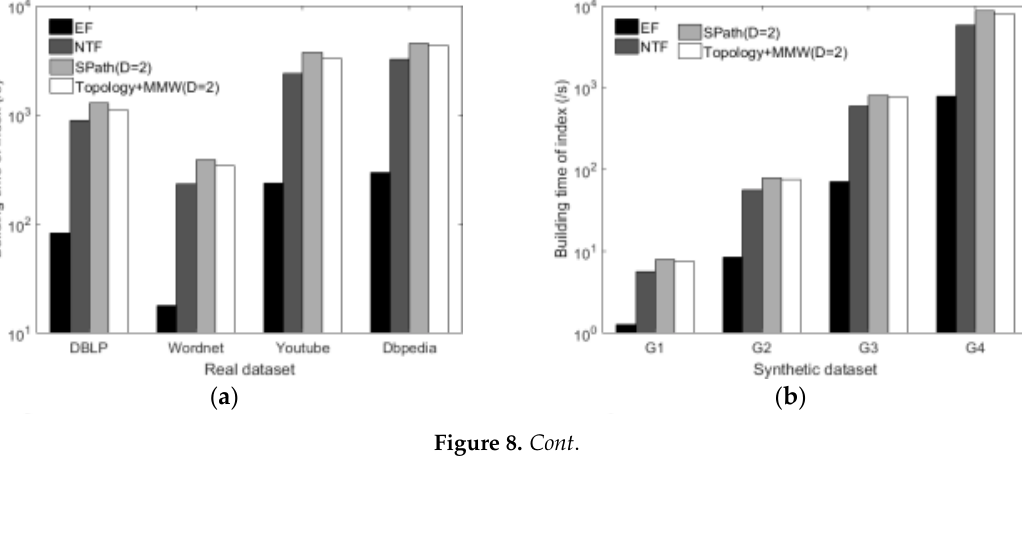
( d ) Figure 8. Comparison of construction time and memory cost for indexes. ( a ) Comparison of construction time in real datasets; ( b ) Comparison of construction time in synthetic datasets; ( c ) Comparison of memory cost in real datasets; ( d ) Comparison of memory cost in synthetic datasets. 6.2.2. Interesting Subgraph Query Efficiency Evaluation Figure 9a–d show the comparison of the query time based on the different real datasets when K = 10. We abstract each dataset into a data graph G. The parameter n (n = 20%, 40%, 60%, 80%, 100%) is the ratio of the nodes contained in the subgraph randomly extracted from the data graph G to the original data graph. In the experiment, for the unweighted query graph (Q 1 ) and weighted query graph (Q 2 ), we observe the query time of each algorithm is changed as the data graph scale increases. Among them, Q 1 is obtained when the query graph Q shown in Figure 2b removes weight, and Q 2 is the query graph Q shown in Figure 2b, and D = 2 in the index of RAM and RWM. For the weighted query graph, the algorithms of RAM and RWM need to query all the matching subgraphs and then to filter the subgraphs that do not meet weight limit conditions. But the DISQtop-k algorithm has filtered out the nodes and edges that do not meet conditions when the candidate set is filtered, which avoids the repeated calculation. So, the DISQtop-k algorithm runs faster and grows flatter. T o ensure each query has at least one match result in the data graph, we generated every query graph by randomly extracting connected subgraph from the data graph.